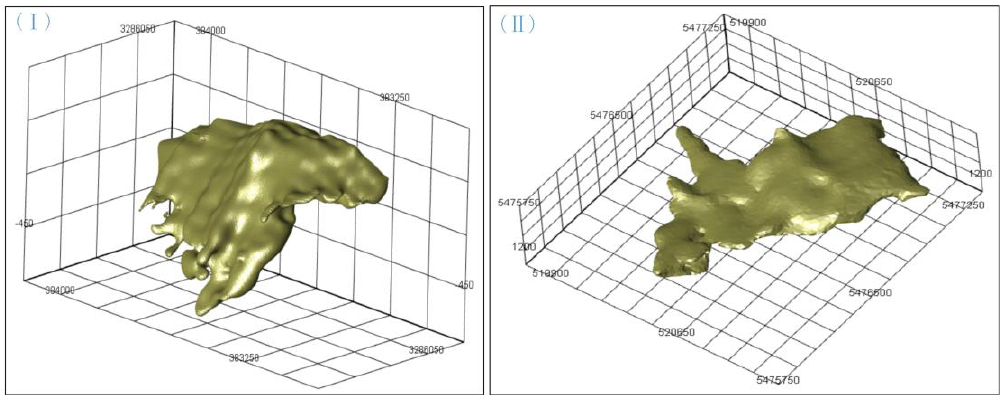
Figure 8. Automatic Modeling Rendering for Case I and Case II.